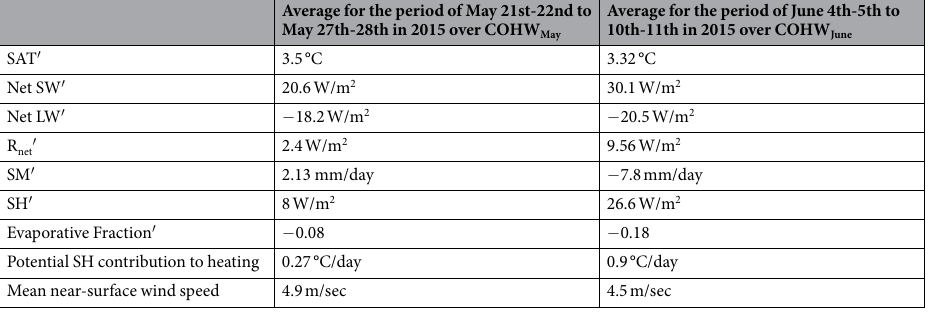
Table 1. Average anomaly of the variables over